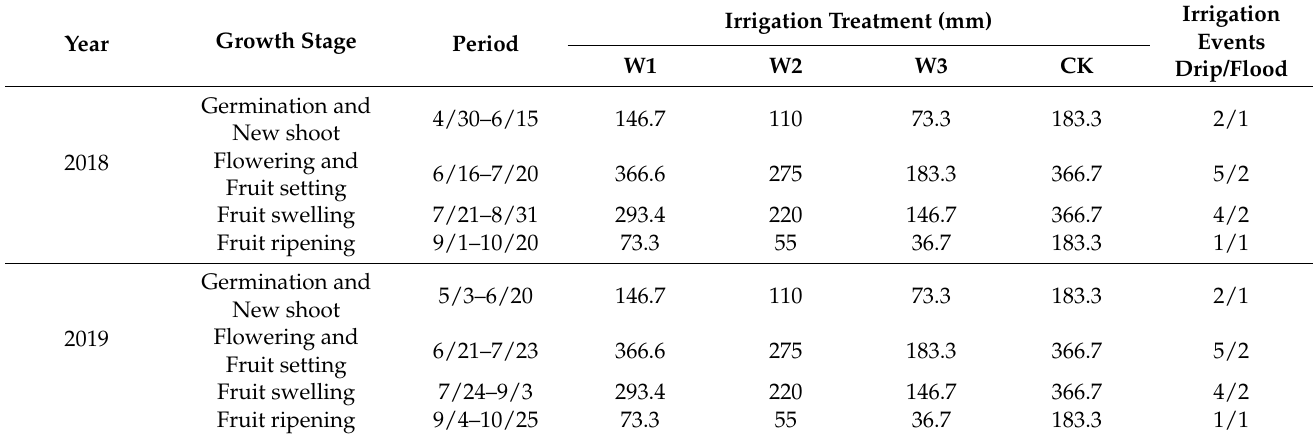
Table 2. Irrigation scheduling of jujube in 2018 and